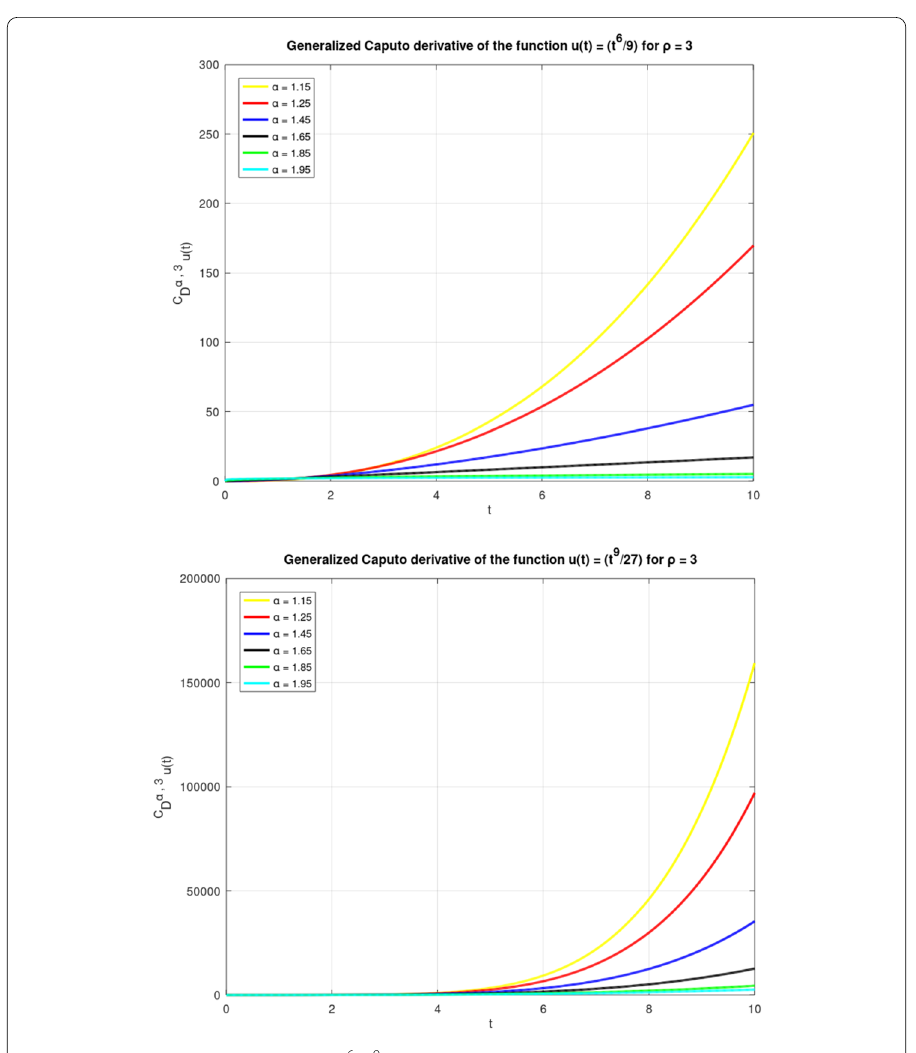
Figure 2 The GCpFr derivative of u ( t ) = t 6